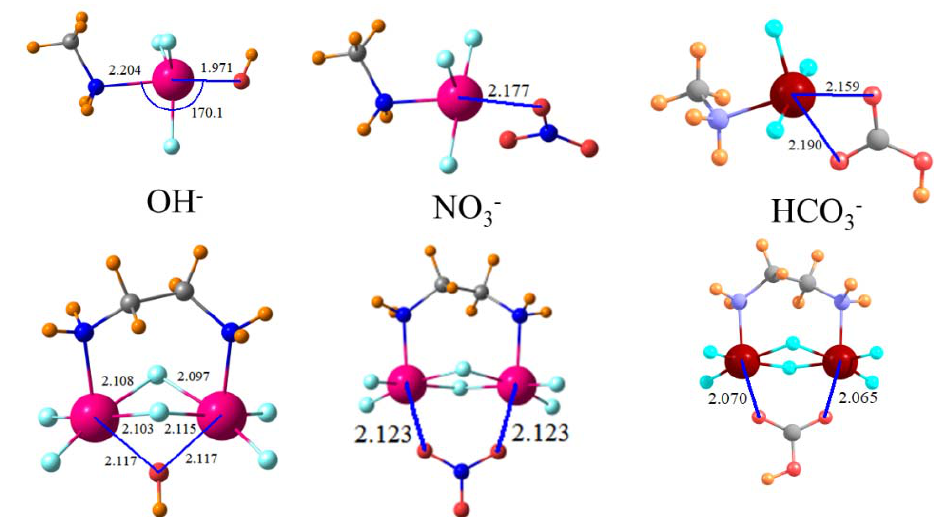
Figure 6. Geometries of indicated anion with CH 3 NH 2 SnF 3+ cation in upper half and F 3 SnNH 2 (CH 2 ) 2 NH 2 SnF 3+2 dication in lower half. Distances in Å.